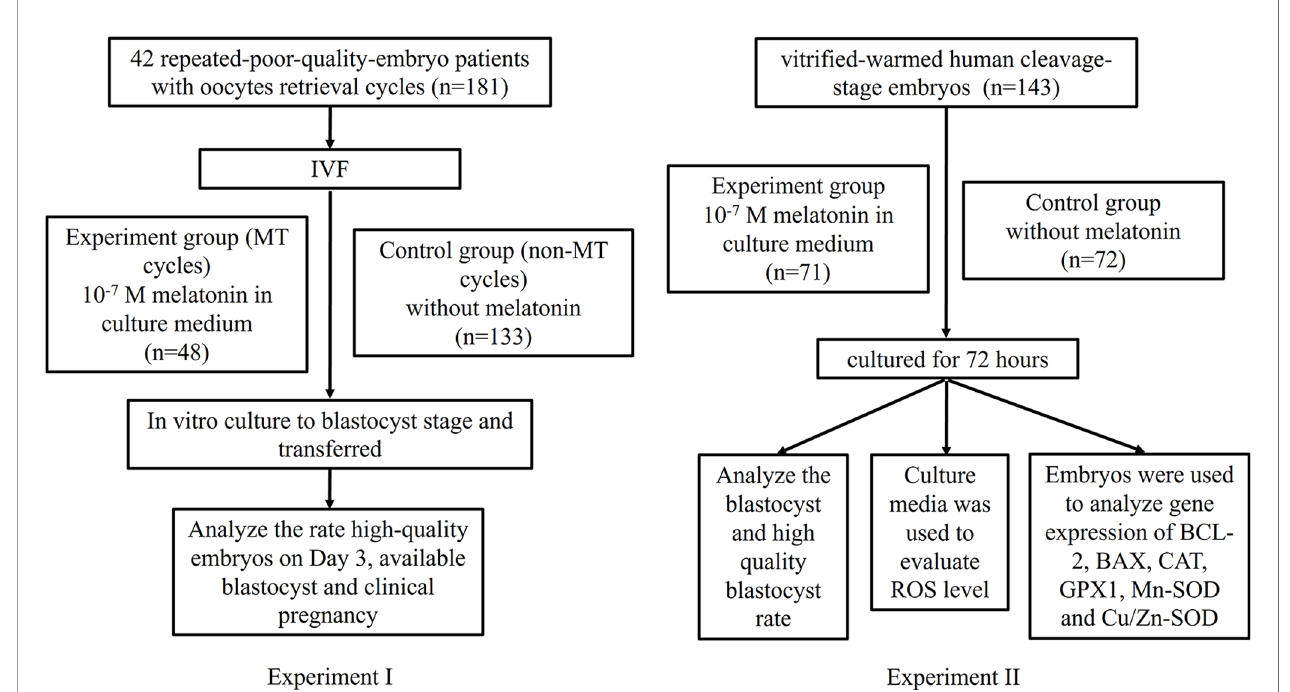
FIGURE 1 | The experimental fl